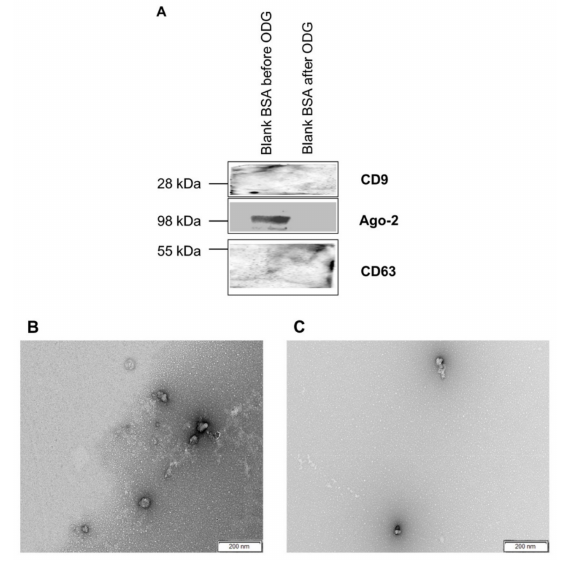
Figure 2. ( A ) Nanoparticle tracking analysis, ( B ) transmission electron microscopy, and ( C ) western blotting were performed to assess the concentration, size, morphology, and presence of EVs isolated from concentrated conditioned medium (CCM). ( A ) The concentration of EVs from 1 mL of bovine embryo conditioned medium (obtained from a pool of 500 embryos) was 40.8 × 10 8 particles/mL and their size ranged between 25 nm and 250 nm. ( B ) Images demonstrate different EVs indicated with red arrows, size ranging from 25 nm to 250 nm. ( C ) The presence of EVs in OptiPrep™ density gradient (ODG) ultracentrifugated embryo conditioned medium (fraction 8–9); and blank BSA medium after (fraction 8–9) ODG ultracentrifugation was tested using two EV specific (CD63, CD9). EVs isolated from bovine follicular fluid (FF) were included as positive control